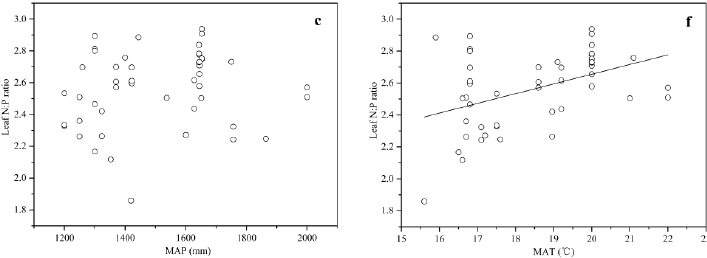
Figure 4. Relationships between the leaf stoichiometry and climatic variables for Chinese fir. Each data point represents an ln (N + 1)-transformed leaf N or P concentration or leaf N:P ratio. Linear fit for ( e ) the leaf P and MAT (mean annual temperature) ( R 2 = 0.11, p < 0.05); and ( f ) the leaf N:P ratio and MAT ( R 2 = 0.17, p < 0.01). No fit for ( a ) the leaf N and MAP (mean annual precipitation); ( b ) the leaf P and MAP; ( c ) the leaf N:P ratio and MAP; and ( d ) the leaf N and MAT. 3.4. Variations of the Leaf N and P Concentrations and N:P Ratio with Soil Nutrient Concentrations No linear or nonlinear relationships were found between the leaf N concentration and soil N concentration (Figure 5a), while the leaf P concentration and the leaf N:P ratio showed a negative and positive correlation with the soil N concentration, respectively (Figure 5b and c). It seemed that the variation of the soil P concentration did not cause changes in the leaf N and P concentrations and N:P ratio (Figure 5d, e, and f).